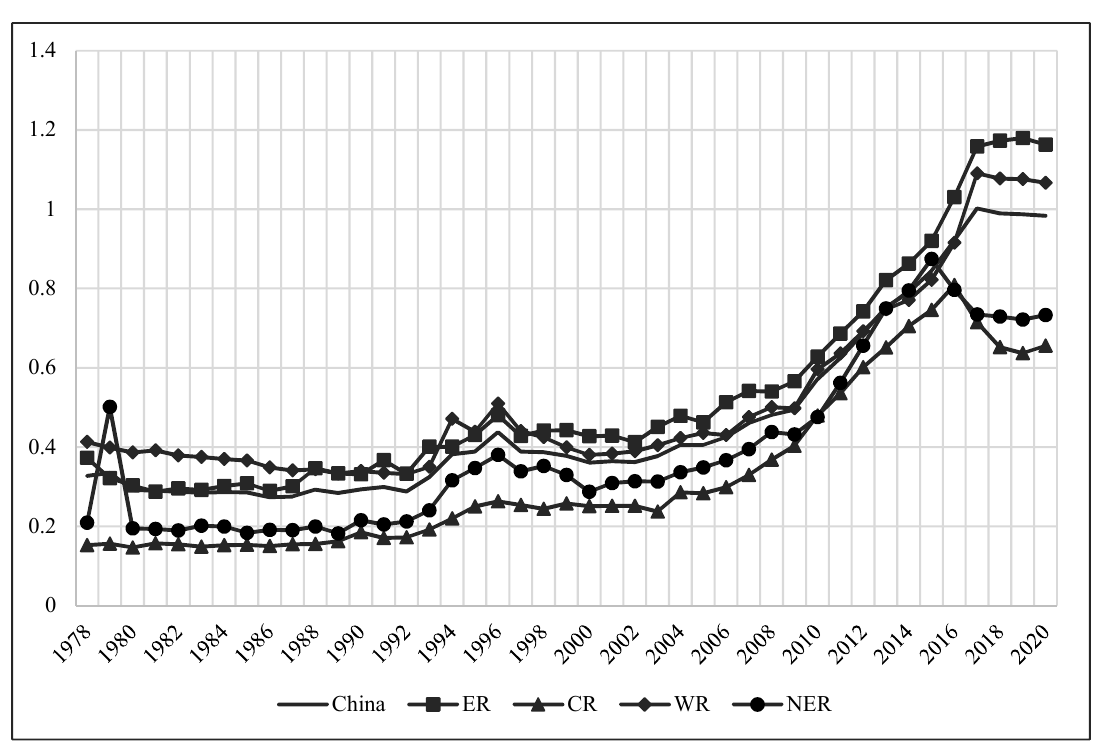
Figure 1. Evolution of AEE in China from 1978–2020. The reference for economic division is available online: http://www.stats.gov.cn/ztjc/zthd/sjtjr/dejtjkfr/tjkp/201106/t20110613_71947.htm (accessed on 25 March 2022), which contains 10 provinces in the ER, including Beijing, Tianjin, Hebei, Shanghai, Jiangsu, Zhejiang, Fujian, Shandong, Guangdong and Hainan; 6 provinces in the CR, including Shanxi, Anhui, Jiangxi, Henan, Hubei and Hunan; 12 provinces in the WR, including Inner Mongolia, Guangxi, Chongqing, Sichuan, Guizhou, Yunnan, Tibet, Shaanxi, Gansu, Qinghai, Ningxia and Xinjiang; and 3 provinces in the NER, including Liaoning, Jilin and Heilongjiang (Tibet, Hong Kong, Macao and Taiwan are not included in this study).